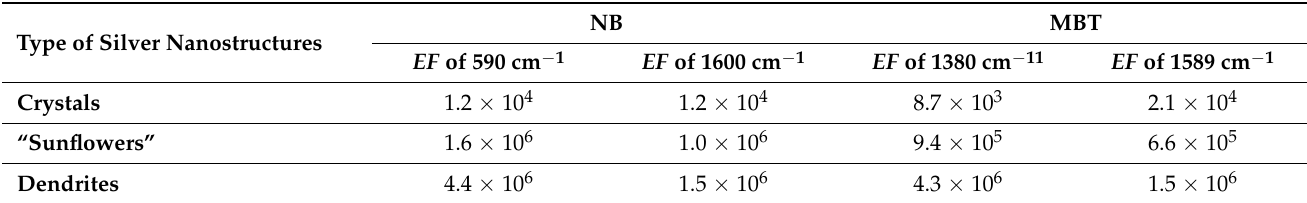
Table 3. EF of Raman lines for NB (590 cm -1 и 1600 cm -1 ) and MBT (1380 cm -1 и 1589 cm -1 ) molecules obtained using different type of silver nanostructures in SiO 2 /Si